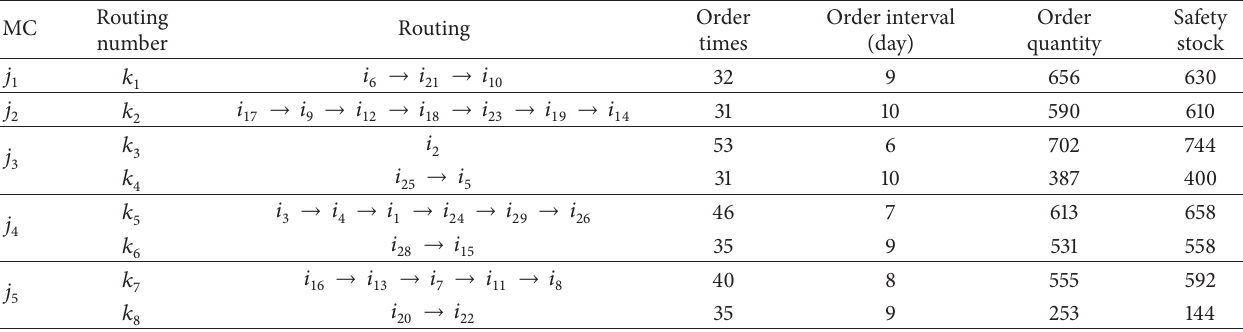
Table 6: Solution of instance Gaskell 67 − 29 × 5.